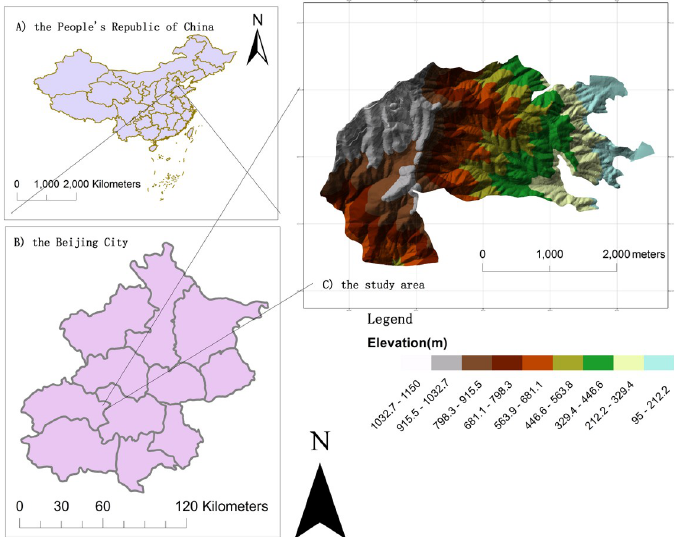
Fig 1. Study area and DEM of Jiufeng National Forest Park, Beijing,